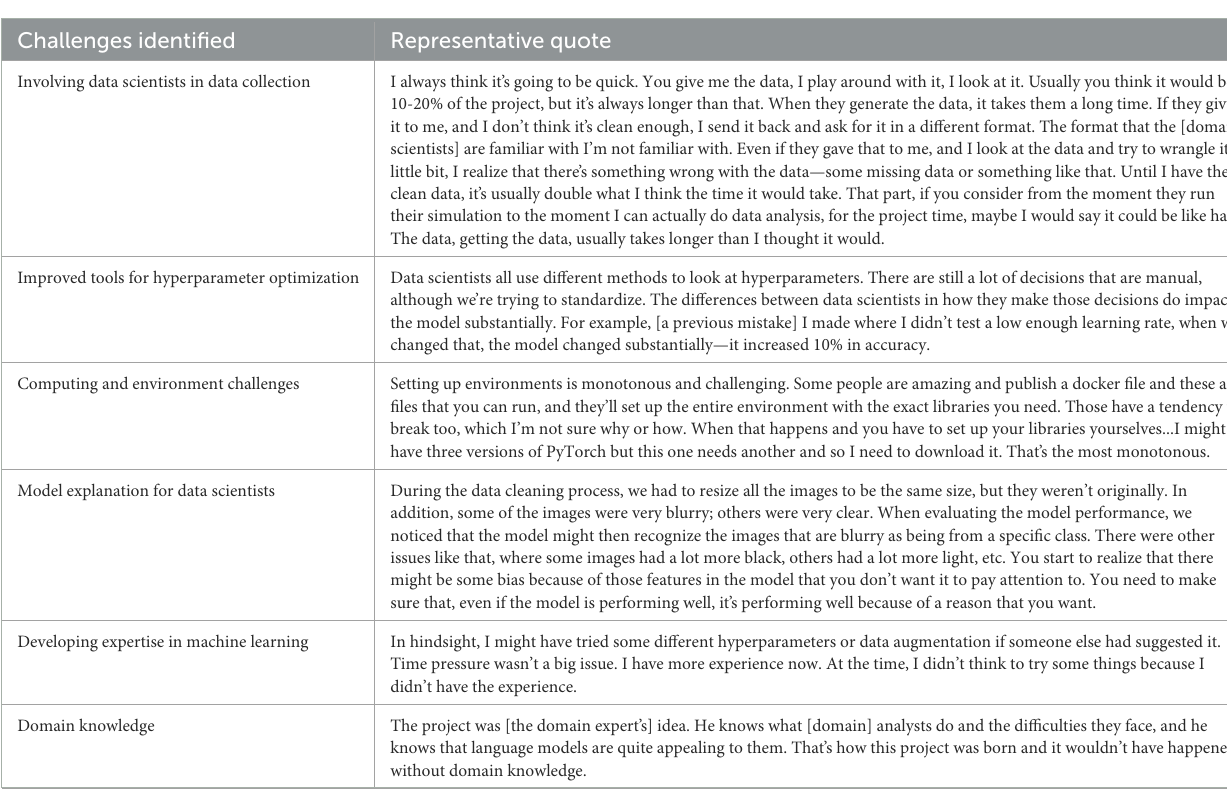
TABLE 3 Representative notes for each